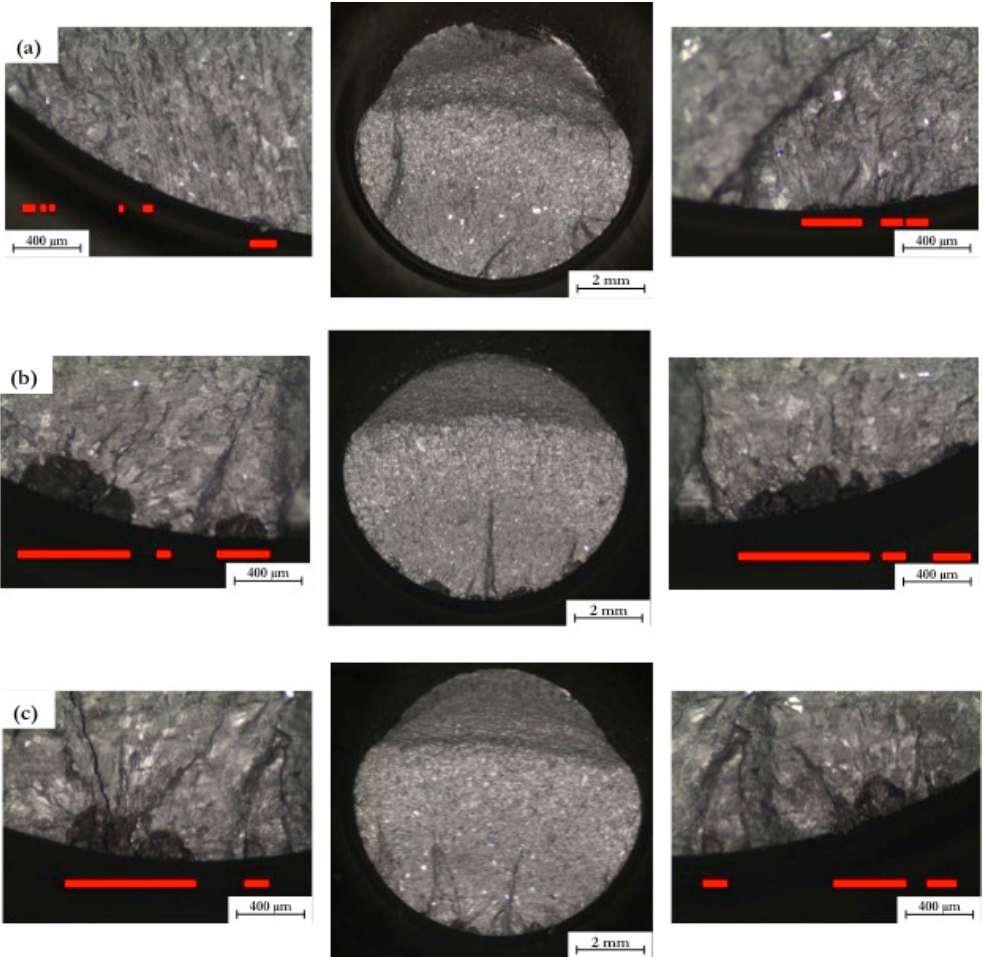
Figure 10. Fracture surfaces and details of the initiation zone obtained from interrupted tests in PWR environment ( a ) SIS A, 300 cycles, ( b ) SIS A, 600 cycles, and ( c ) SIS B, 300 cycles.